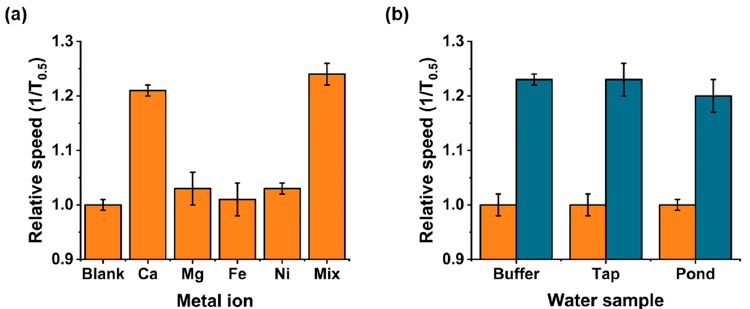
and “b)” to “(a)” and “(b)” in the picture.